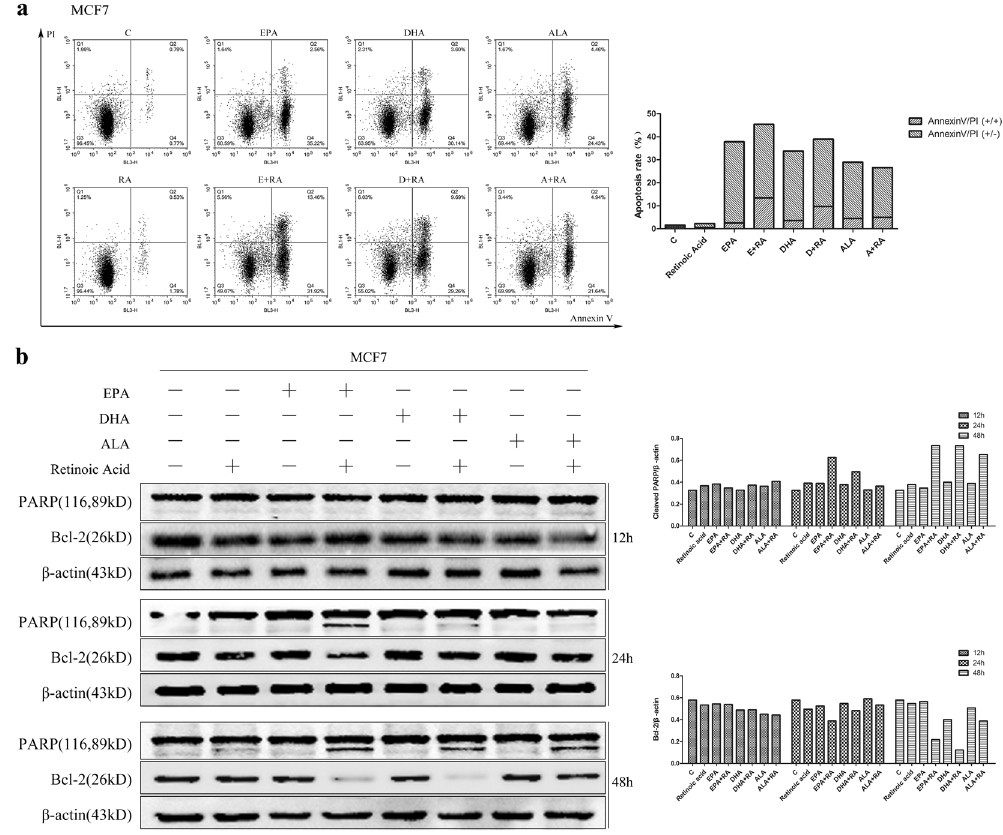
Figure 3. Cell apoptosis. MCF7 cells were treated with 80 μ M ω - 3 FFAs and 20 μ M ATRA. ( a ) Cell apoptosis was analyzed by flow cytometry with PI and Annexin V-FITC staining and percentage of apoptotic cells at two different stages. ( b ) PARP and Bcl-2 protein level after treatment from 12 h to 48 h. β -Actin was used as an internal